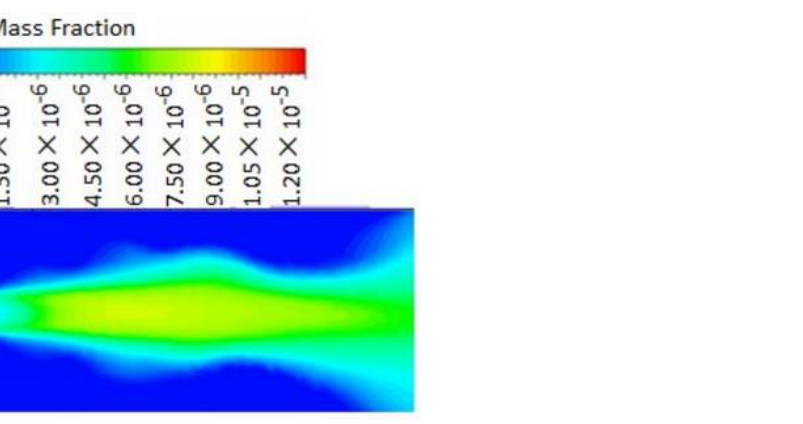
Figure 9. Building a mathematical model of the carbon oxide distribution based on the data col- lected by the neural network.